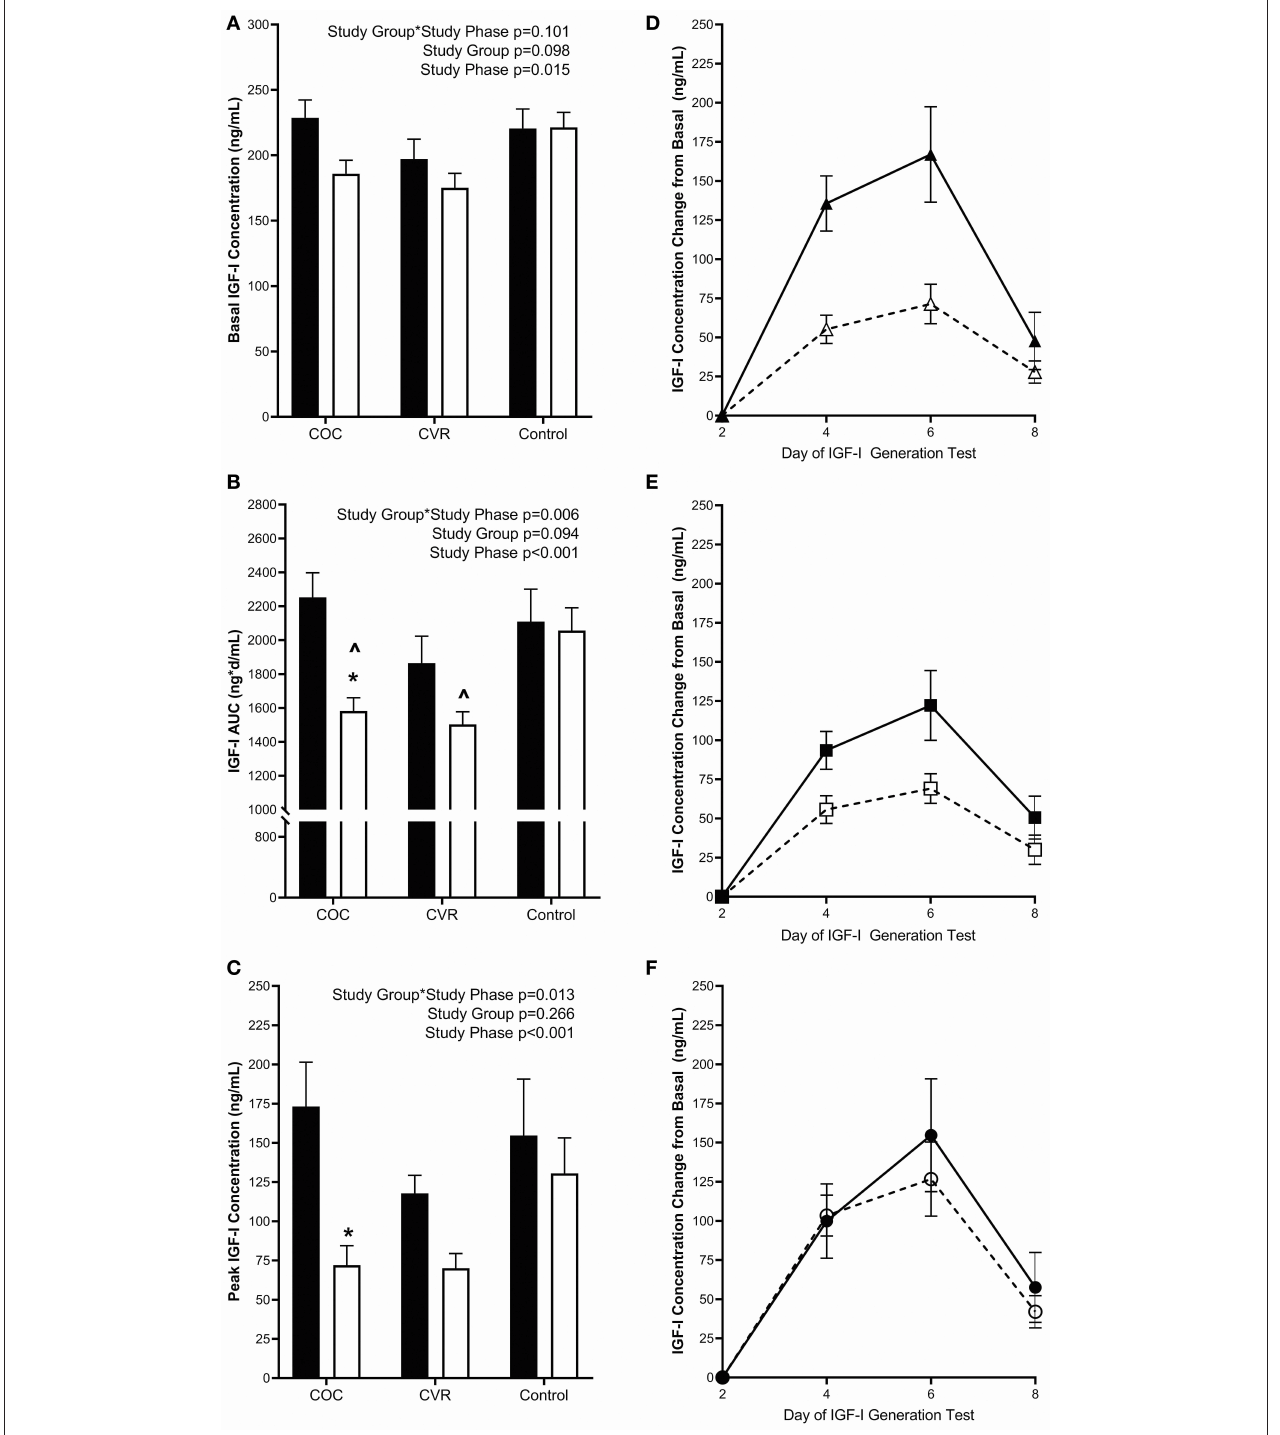
FIGURE 4 | Pre-intervention (black bars) and intervention (open bars) IGF-I (A) basal concentrations and response to the IGF-I Generation Test measured as (B) AUC and (C) peak concentrations for the COC, CVR, and Control Groups. (D–F) Daily concentrations of IGF-I for pre-intervention (solid lines and filled symbols) and intervention (dashed lines and open symbols) phase IGF-I Generation Tests. (D) COC group (triangles); (E) CVR group (squares); (F) Control group (circles). Basal IGF-I concentrations were subtracted from day 4, 6, and 8 concentrations for each study group and study phase (pre-intervention and intervention. COC, combined oral contraception; CVR, contraceptive vaginal ring; IGF-I, insulin-like growth factor-I; AUC, area under the curve. * indicates difference from pre-intervention phase within study group P < 0.05. ∧ indicates difference from Control group within study phase P < 0.05.